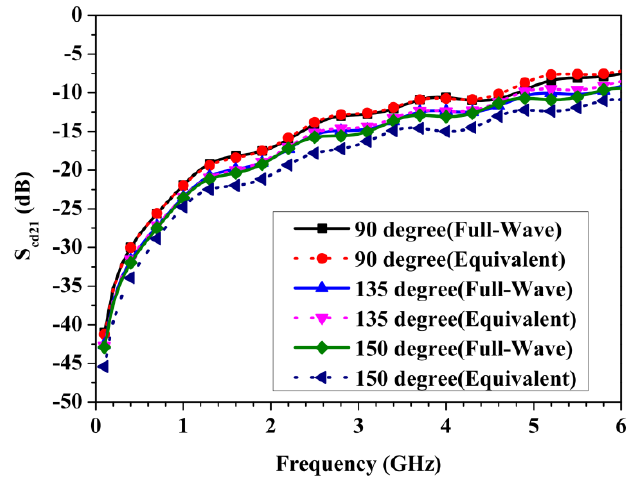
Figure 7. Scd21 simulated results for the full-wave and equivalent circuit models.